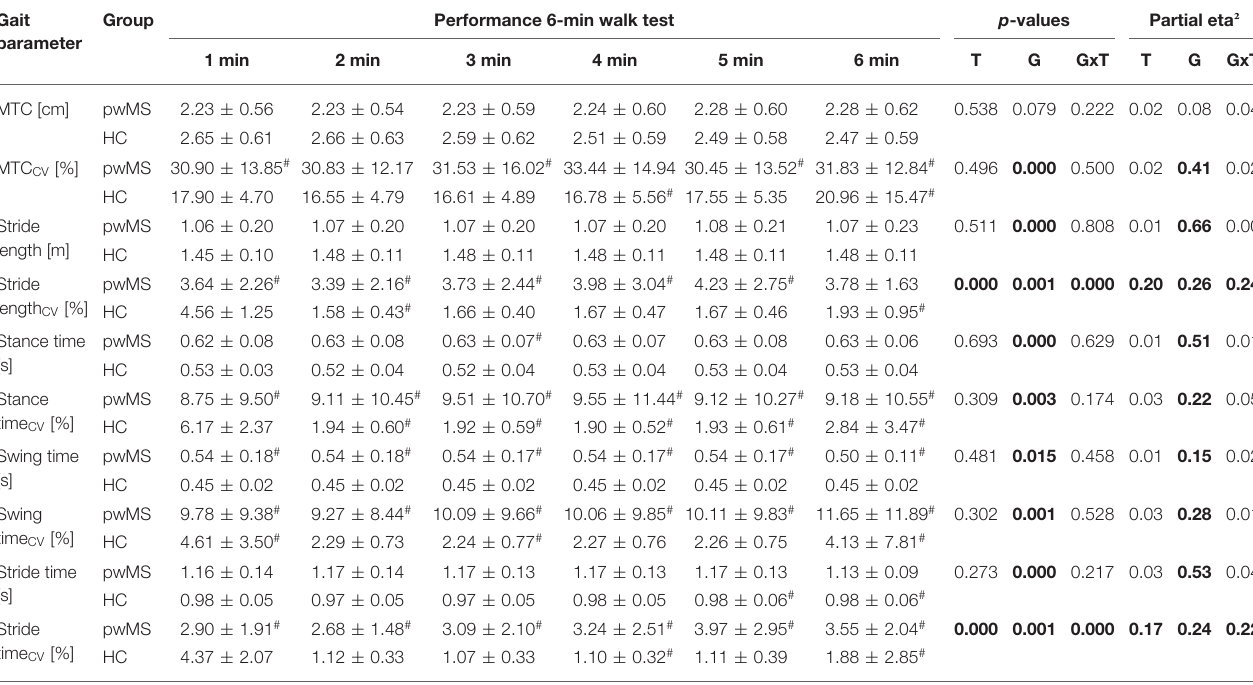
TABLE 3 | Spatio-temporal gait parameters of every minute of the 6-min walk test (mean ± standard deviation) and rmANOVA outcomes ( p -values and effect size partial eta ² ). Gait parameter